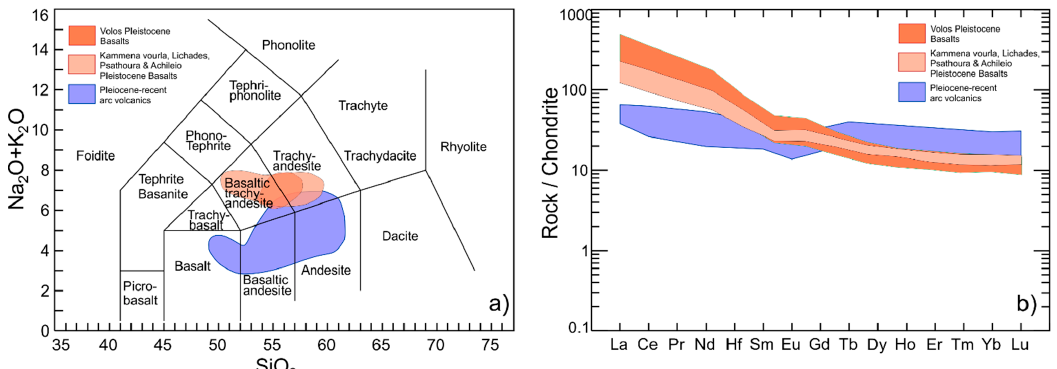
Table 2. Hydrochemical analyses of groundwater samples from Microthives locality [28]. T (°C);